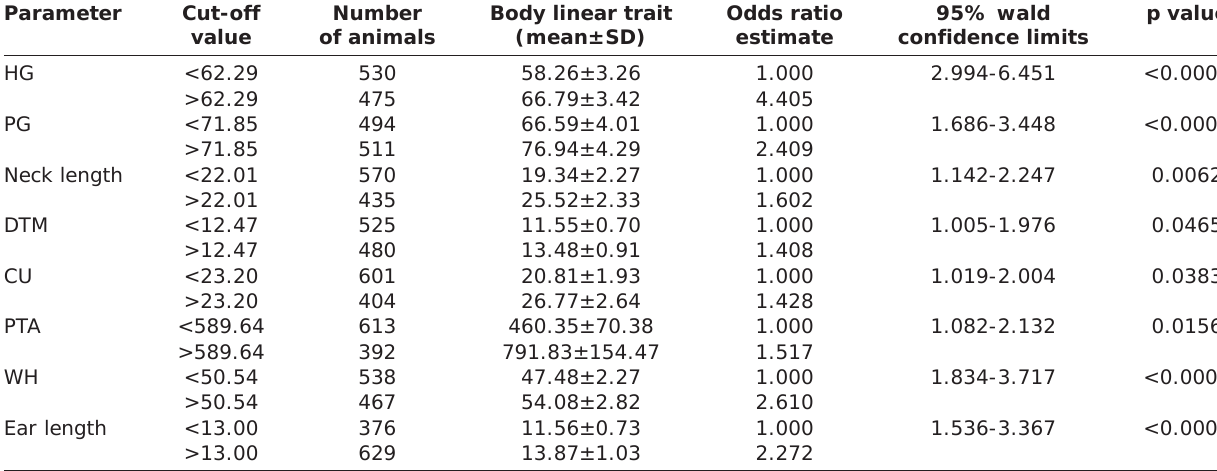
Table-6: Summary of logistic regression model of the influence of various body linear traits on either twin or triplet LZ in Indian Black Bengal goats. Parameter Cut-off